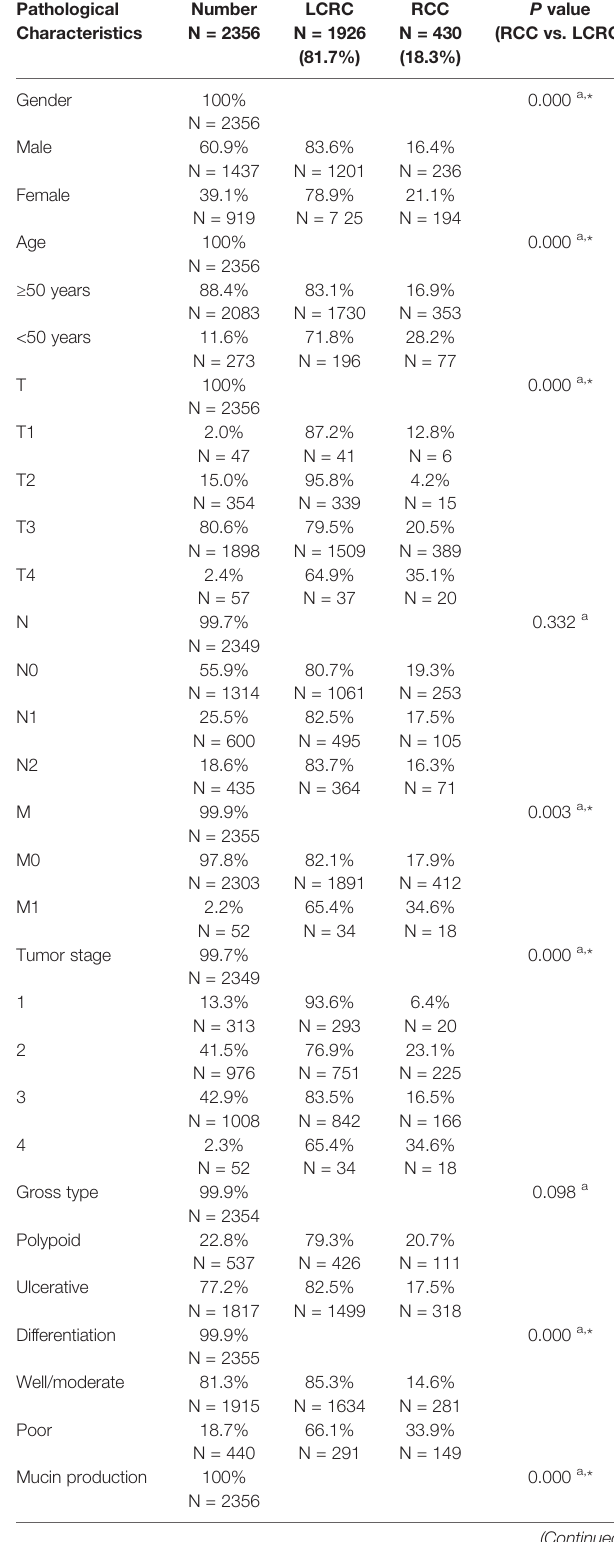
TABLE 2 | Clinicopathological characteristics and tumor